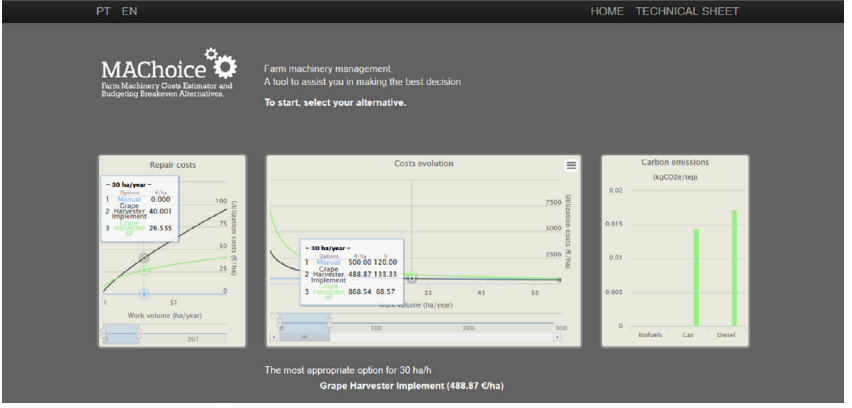
Figure 6: MACHoice’s screen-shot of graphical user interface with the repair costs and costs per-unit-of-work for different alternatives of grape harvesting: manual and mechanical. The carbon emissions for the self-powered machines is presented in the graphic on the left side of the